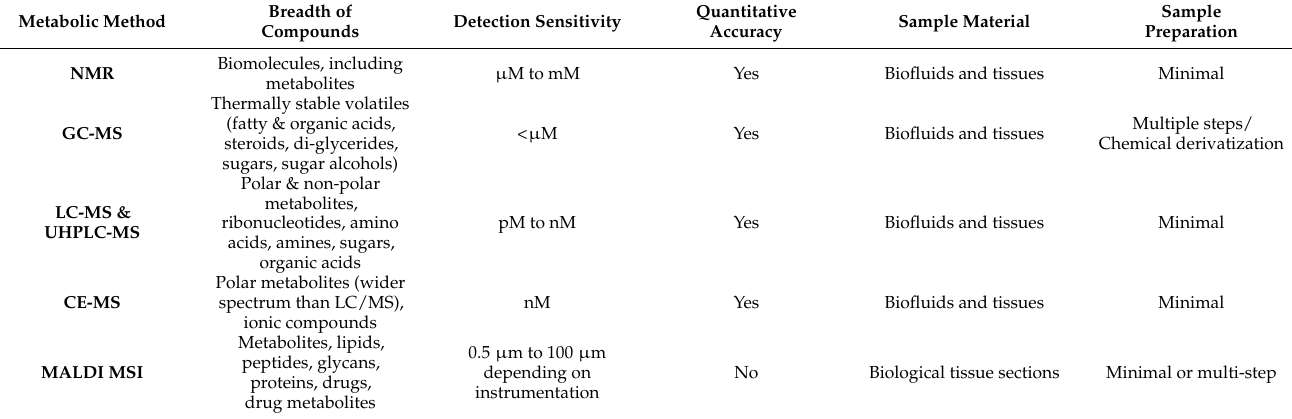
Table 2. Comparative assessment of metabolomic techniques in terms of breadth of compounds detected, sensitivity, and spatial resolution on tissues, quantitative accuracy, type of sample ma- terial, and sample preparation required [124,127,131–133]. NMR: Nuclear Magnetic